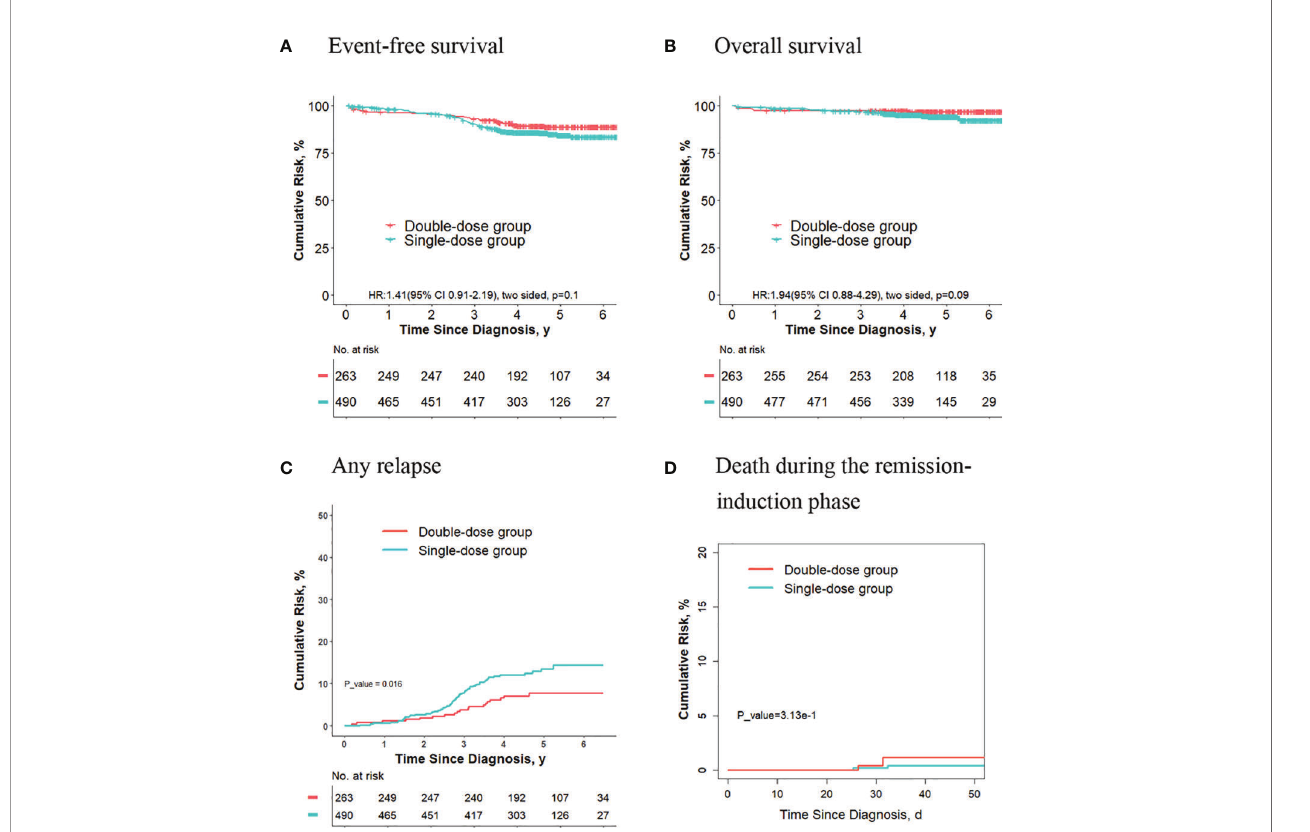
FIGURE 3 | Analysis of survival and cumulative risk of relapse and early death for fi nal low-risk patients with ALL who didn ’ t meet the criteria for the second dose of